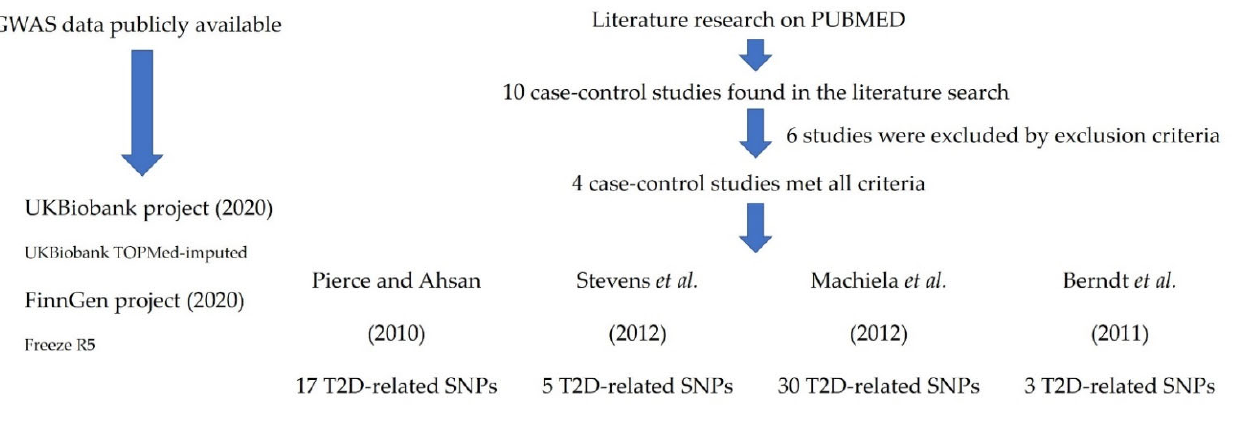
Figure 1. Flow diagram of the study [20–22,71].